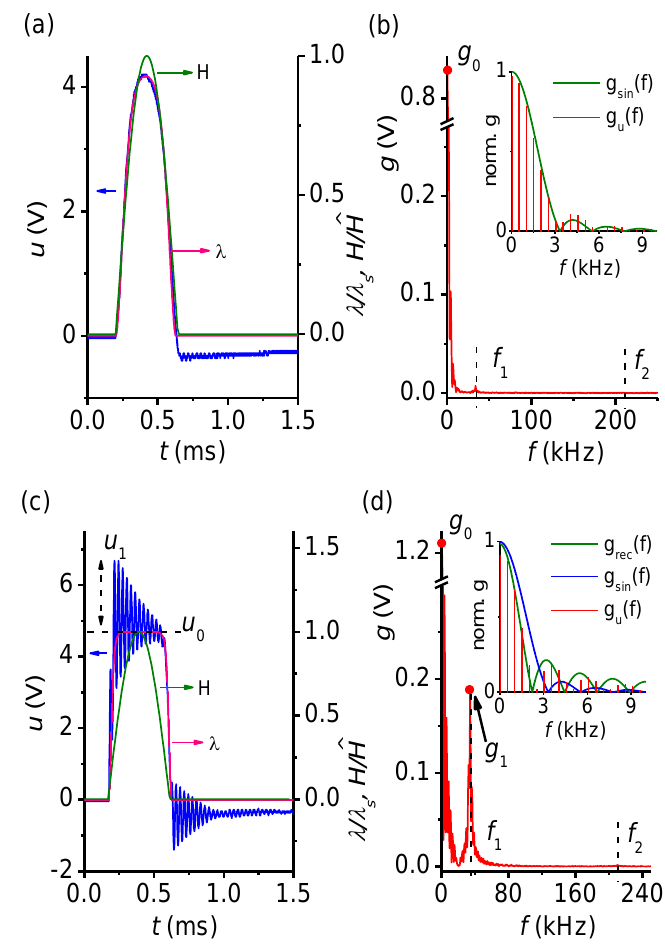
Figure 3. The time dependence u ( t ) and the frequency spectra g ( f ) of voltage pulses generated by CoFe/PZT structure when excited by magnetic field pulses with different amplitudes Ĥ : ( a ) and ( b ) −1.5 kOe, ( c ) and ( d ) −6.5 kOe, ( e ) and ( f ) −38 kOe. Here and in the following u denotes the amplitude of voltage pulse without oscillations. The insets o compare the spectrum of the voltage pulse g ( f ) with that of a half-sine pulse g ( f ) and of a u sin rectangular pulse g ( f ) with the pulse length τ , with their values normalized at f = 0 rec